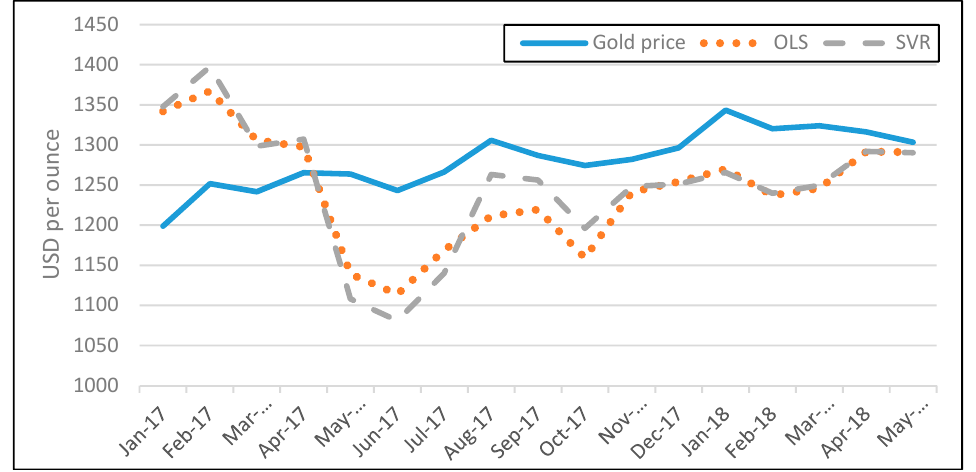
Figure 9. Out-of-sample 12-month ahead gold prices forecasts for China based on the GPR index for the SVR and OLS model for the period Jan-2017 to May-2018.